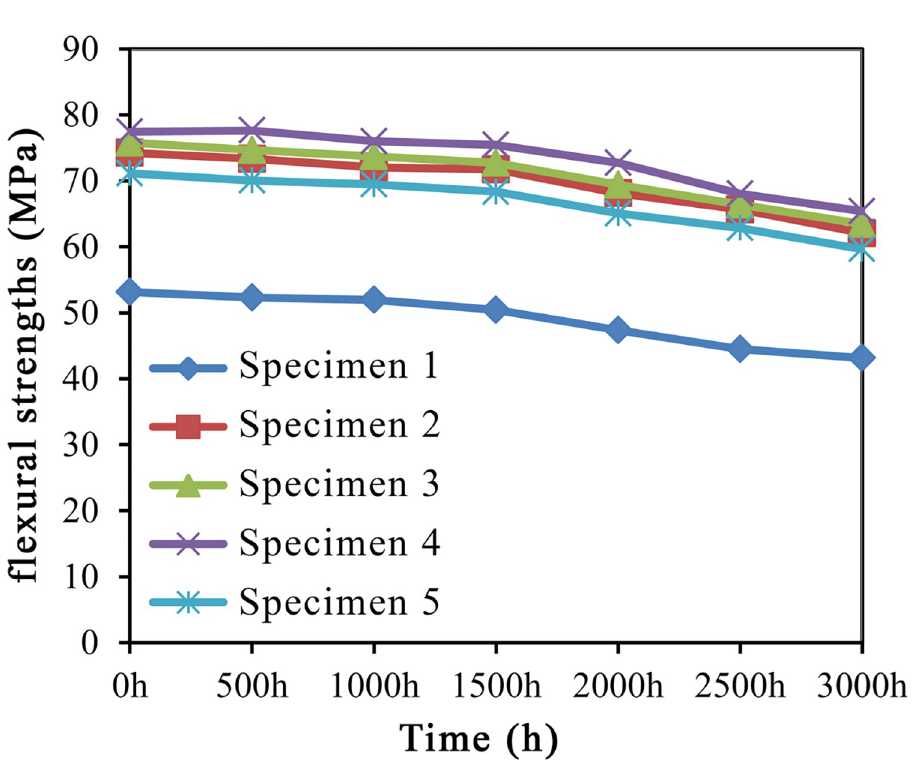
Fig 3. Variation trends of flexural strengths.